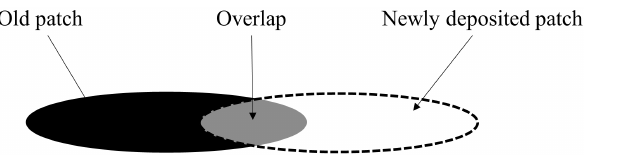
Figure 2. Difference in the chemical composition of the soil in two urine patches deposited at different times. The different colours of the old and the newly deposited urine patches (black and white, respectively) as well as the overlap between them (grey) show the different soil chemical properties in the different